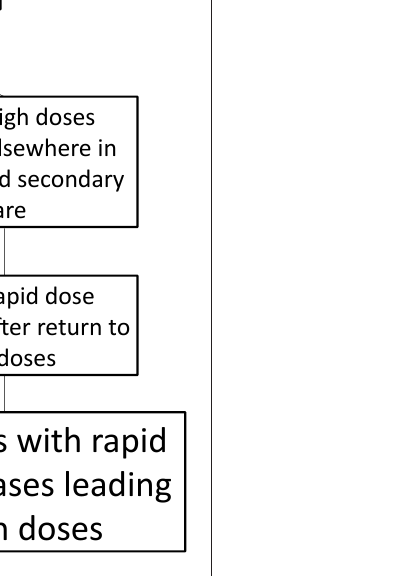
Figure 1 . Identification of patients with rapid dose increases. Figure 1 Identification of patients with rapid dose